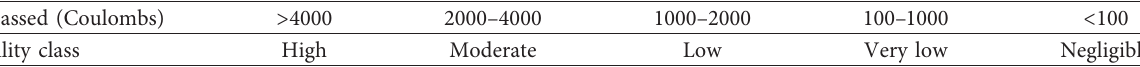
Table 3: Classification of concrete chloride ion penetrability (ASTM C